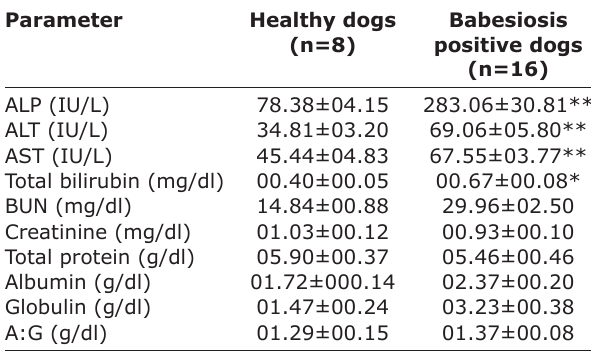
Table-3: Hematological parameters (mean±SE) in healthy and babesiosis positive dogs. Parameter